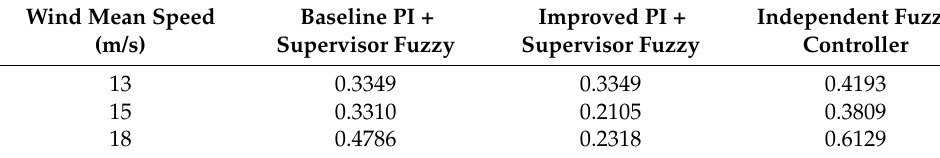
Table 3. GI: Generation Index (MW).